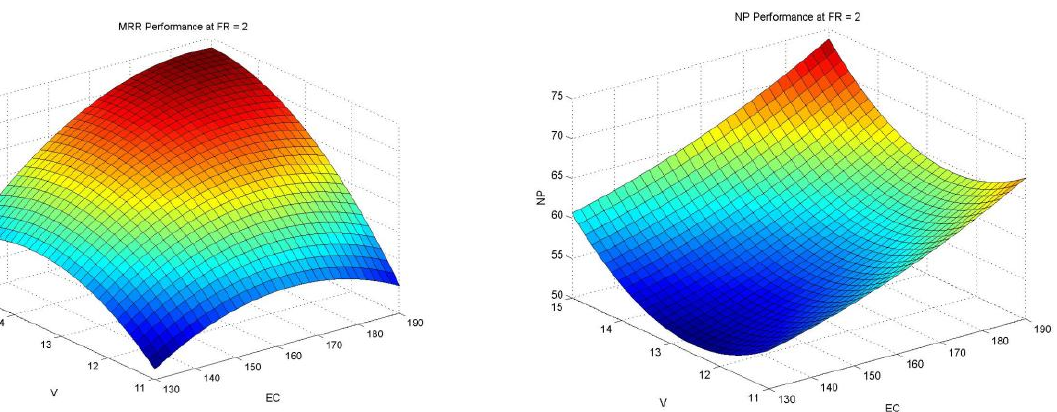
Figure 7. Normal probability plots for MRR and NP.